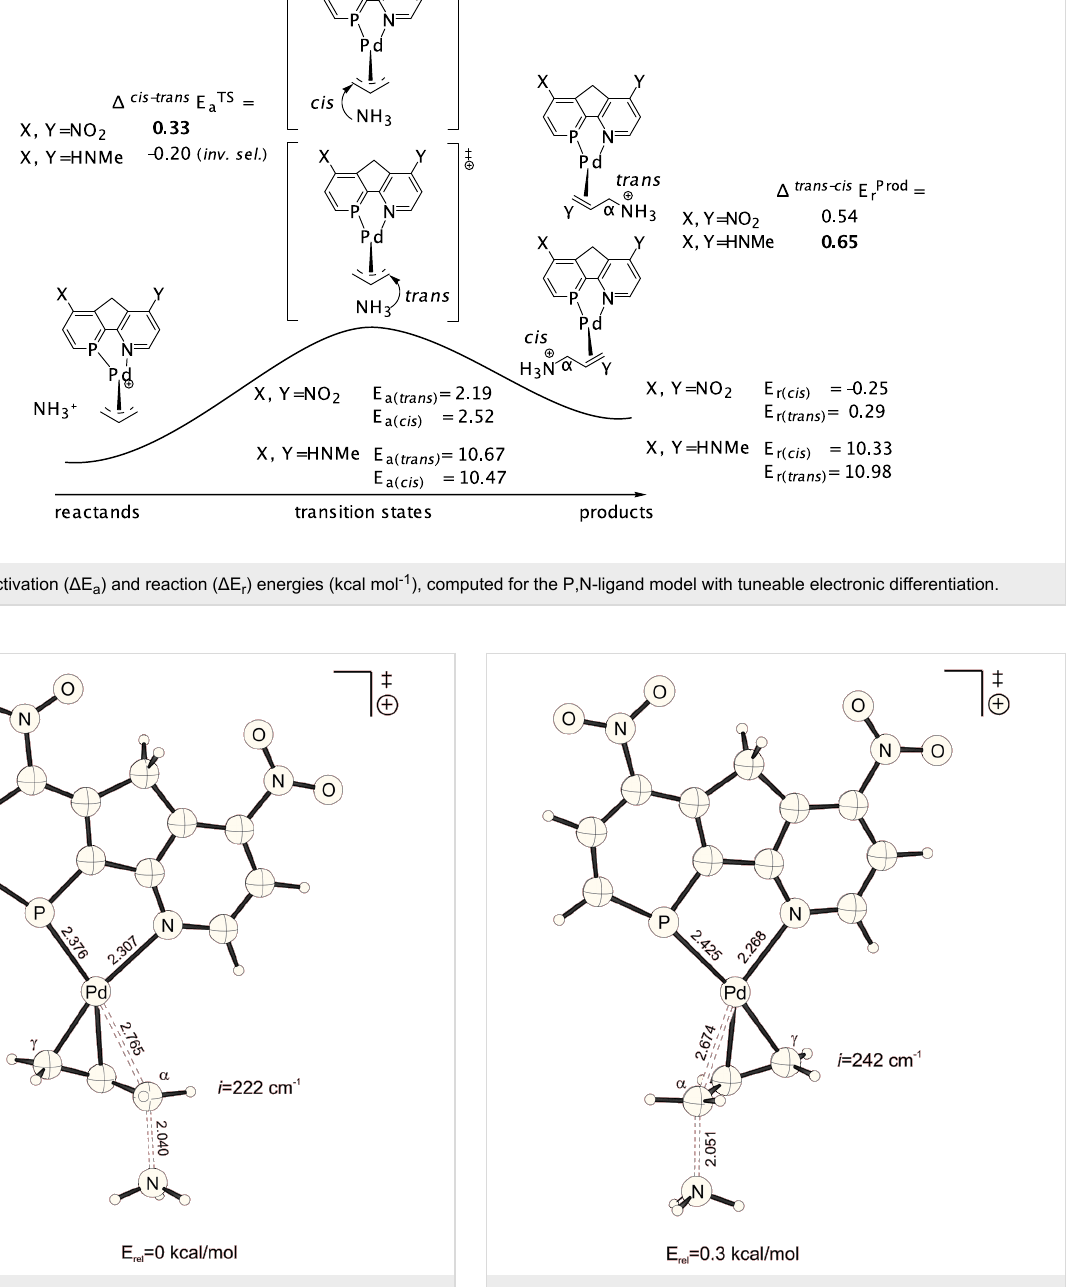
= -0.25 kcal mol -1 ) and becomes most unfavourable (i.e. endo- thermic) for X, Y = NHMe (E r trans = 10.98, E r cis = 10.33 kcal mol -1 , Table 1, Scheme 2). This points to a more π-donating character of the ene product relative to the allyl-cation reactant.